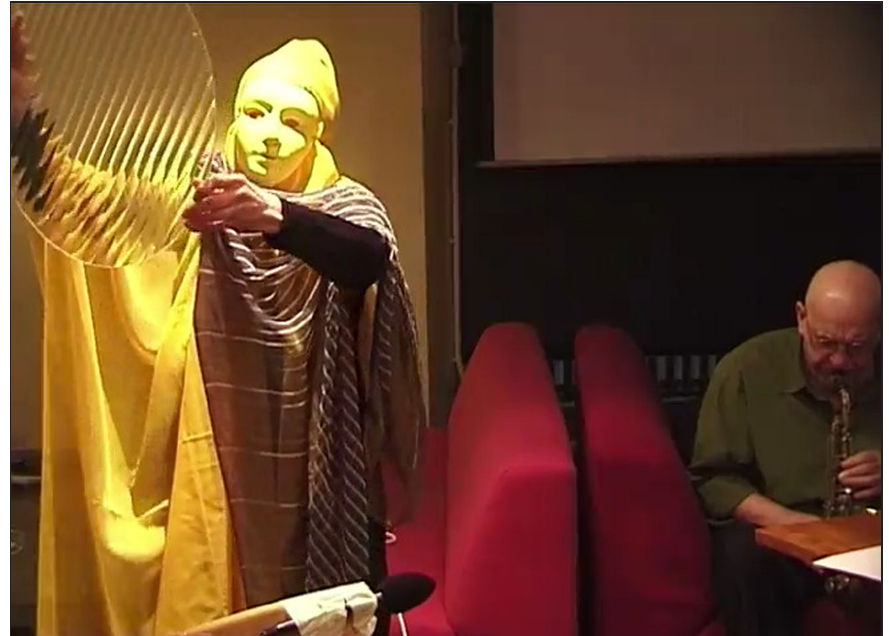
Figure 1.2: (24.31) Jennifer Pike and Lol Coxhill with Birdyak at the RCA, London 2002. Courtesy of William Cobbing, Maddie Coxhill and Ulrike Coxhill-Scholz.